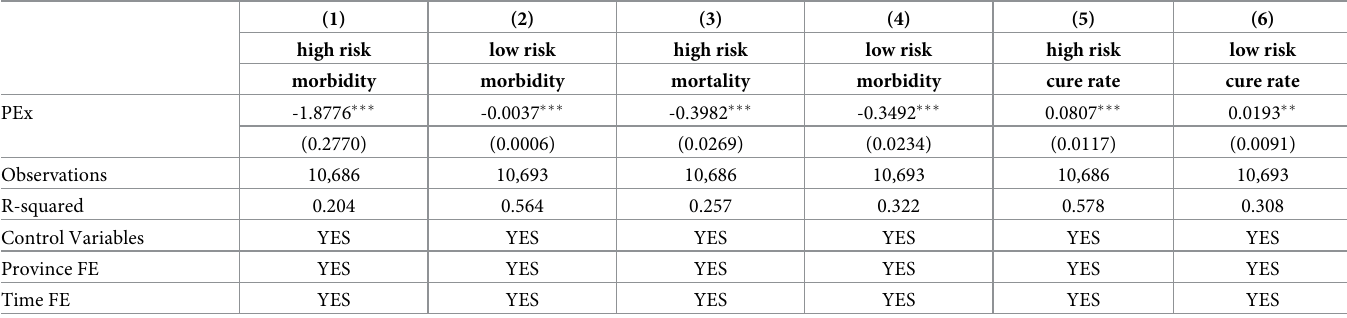
Table 4. Heterogeneity